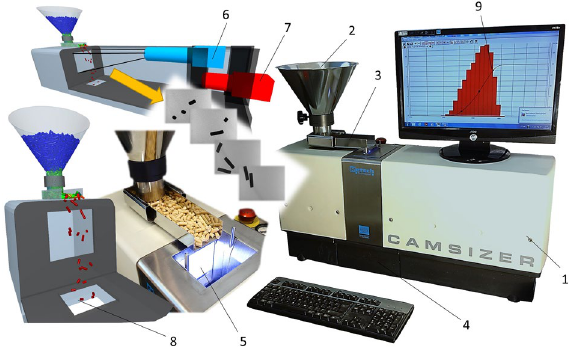
Figure 2. Camera particle analyser—CAMSIZER. 1—device cover, 2—filling funnel, 3—vibrating feeder, 4— catch vessel, 5—illuminated measuring cell, 6—CCD camera zoom 1, 7—normal CCD camera 2, 8—exit hole, 9—PC with software.